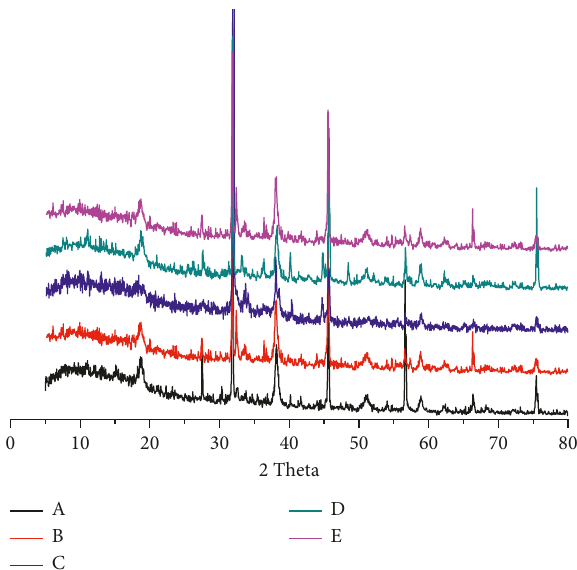
Figure 2: XRD of prepared